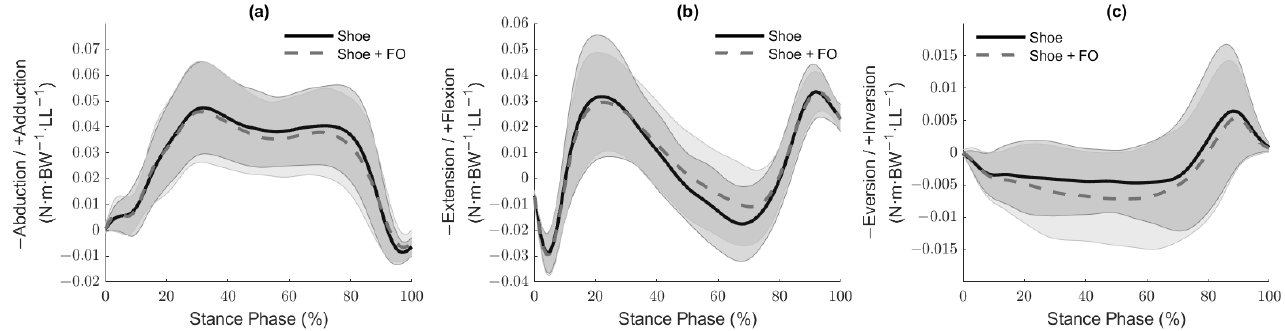
Figure 6. External joint moments for ( a ) knee frontal, ( b ) knee sagittal, and ( c ) ankle frontal plane. The black, solid line represents the Shoe condition; the gray dashed line represents the Shoe + FO condition.